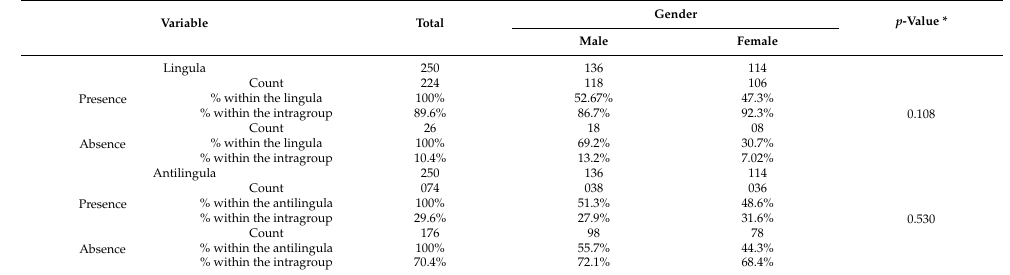
Table 4. Presence of the lingula and antilingula between the genders by the chi-squared test ( n = 250 sides).